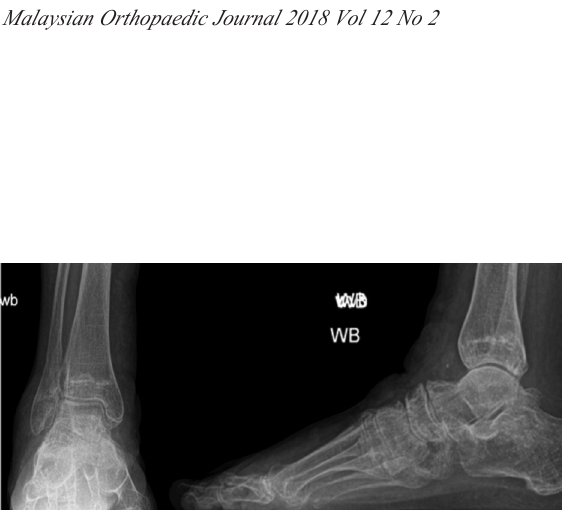
Plain weight-bearing radiographs of foot and ankle Fig. 1: showing normal hind foot alignment.